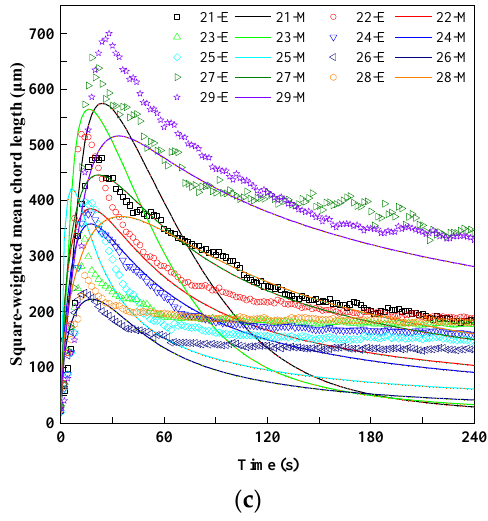
Figure 4. Dynamic evolution of the square-weighted mean chord length of floc obtained by experi- ment (symbols) and modeling (continuous lines) in ( a ) run 1 to 10; ( b ) run 11 to 20, and ( c ) run 21 to 29. In the legend, E and M represent experiment and modeling, respectively. Table 1. Fitted parameters and statistics for each experiment run.